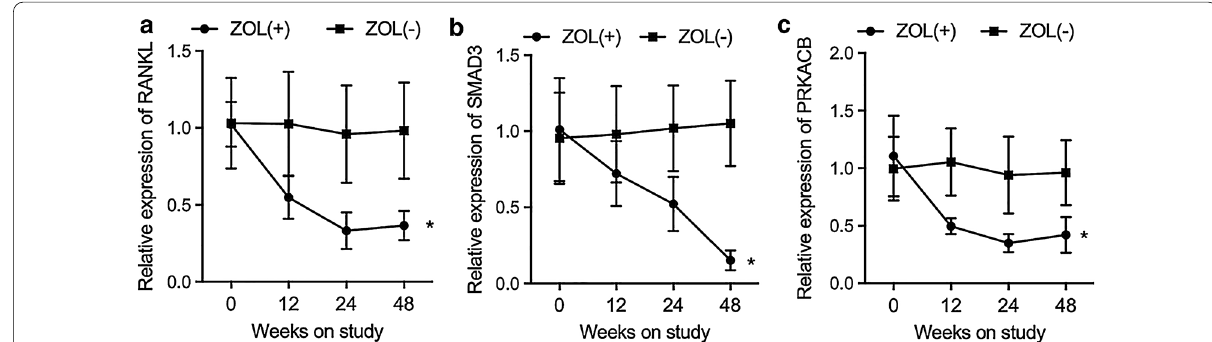
Fig. 4 ELISA analysis showed that the expression of RANKL, SMAD3 and PRKACB was remarkably decreased in the serum of HIV patients receiving tenofovir treatment. a ZOL treatment suppressed the expression of RANKL in the serum of HIV patients receiving tenofovir treatment. b ZOL treatment suppressed the expression of SMAD3 in the serum of HIV patients receiving tenofovir treatment. c ZOL treatment suppressed the expression of PRKACB in the serum of HIV patients receiving tenofovir